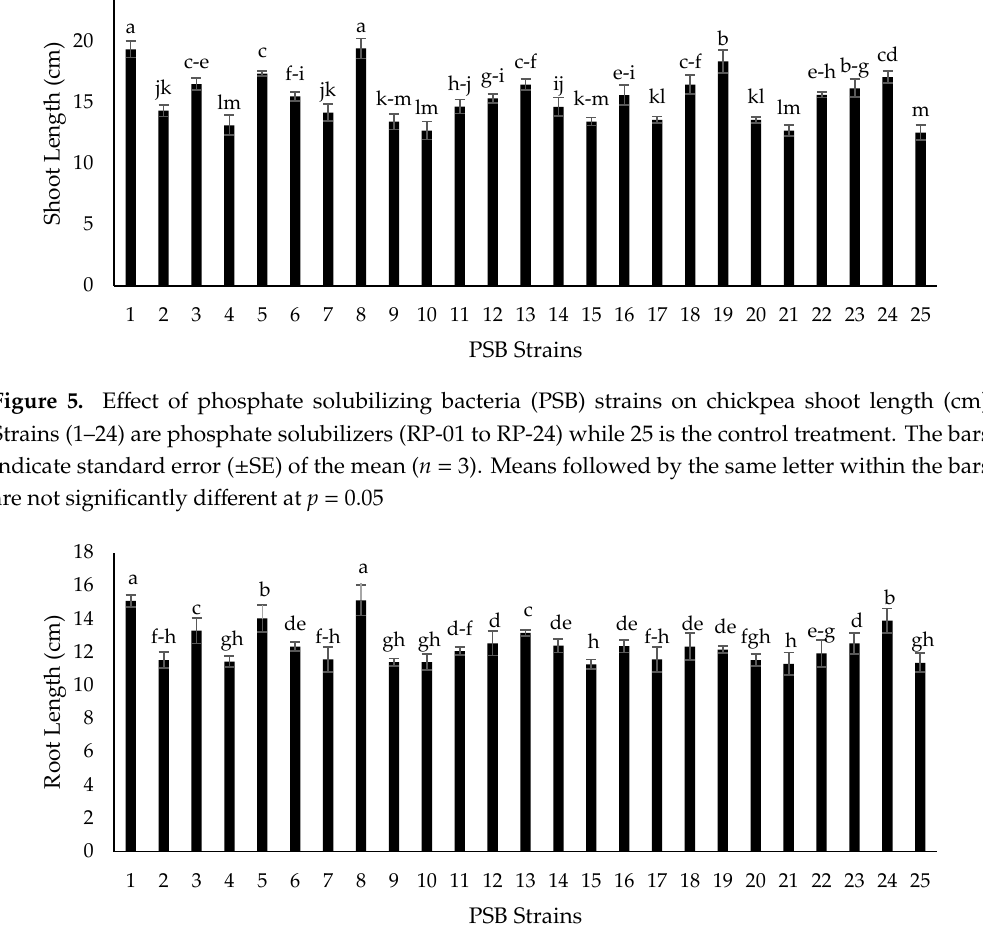
Figure 8. Effect of plant growth promoting rhizobacteria (PGPR) strains on chickpea root length (cm). Strains (1–24) are PGPRs (RS-01 to RS-24) while 25 is the control treatment. The bars indicate standard error (±SE) of the mean ( n = 3). Means followed by the same letter within the bars are not significantly different at p = 0.05. 2.6. Glass House Experiment at Different Moisture Regimes The isolates to be used for making each consortium appeared compatible with each other, thus consortia were built and inoculated to elucidate prominent impact on nodulation, growth and yield attributes of chickpea at different moisture regimes in pots. Maximum number of nodules plant −1 (12.33), plant height (32.37 cm), number of pods pot −1 (20.67), root length (29.61 cm), 100 grain weight (29.84 g), biological yield (38.93 g pot −1 ), grain yield (17.90 g pot −1 ) and harvest index (44.67%) were recorded with T2 ( Mesorhizobium ciceri RZ-11 + Bacillus subtilis RP-01 + Bacillus mojavensis RS-14) at moisture level 1 (55% of soil field capacity) (Table 4). However, grain yield obtained under this treatment was at par to the un-treated control (T9) at moisture level 3 (95% of field capacity). Similarly, statistically higher biological and grain yield (23.17 g pot −1 ) was obtained by T7